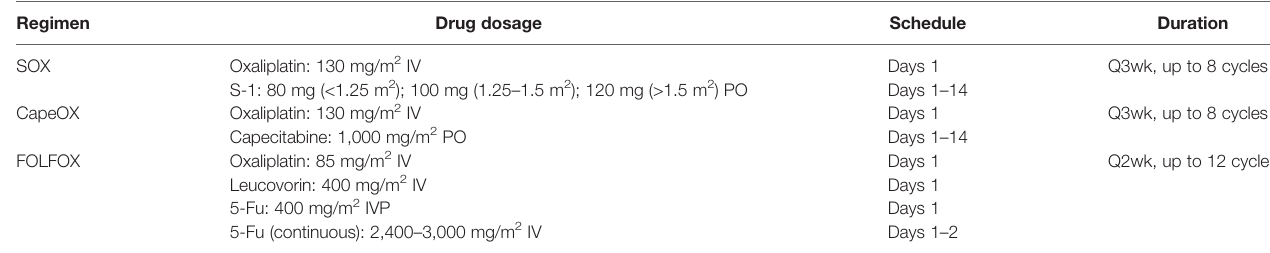
TABLE 1 | Dosage and schedule of the treatment